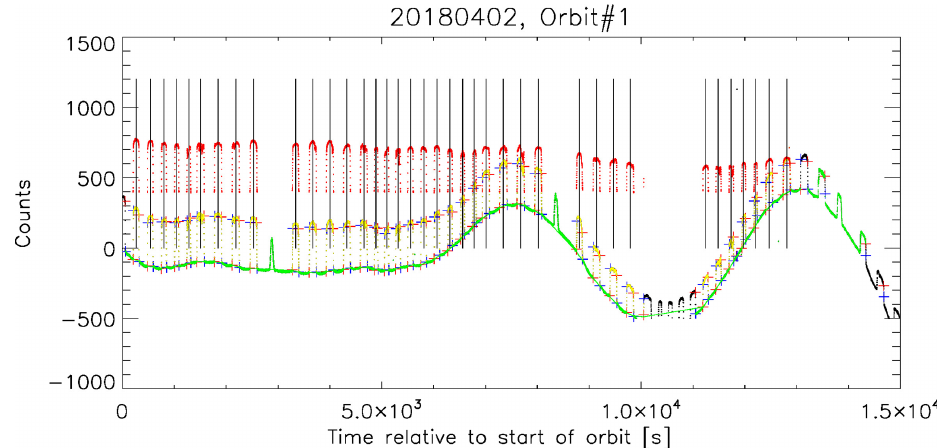
Figure B2. Same with Fig. 3, except this is the final step for the case in Fig. B1. The final polynomial fitting to the space-view counts only is a very necessary step to capture the slowly varying component of the time series, which was failed to be captured in the step 3 based on Fig. B1c using all-sky counts. Please note that the date format in this figure is year month